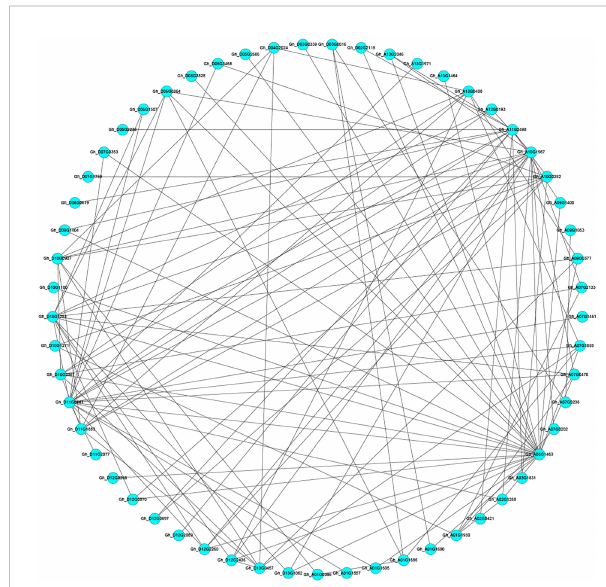
FIGURE 2 Analysis of predicted candidate gene protein interactions. Each circle in the fi gure represents a gene, and the lines between the circles represent interactions between different